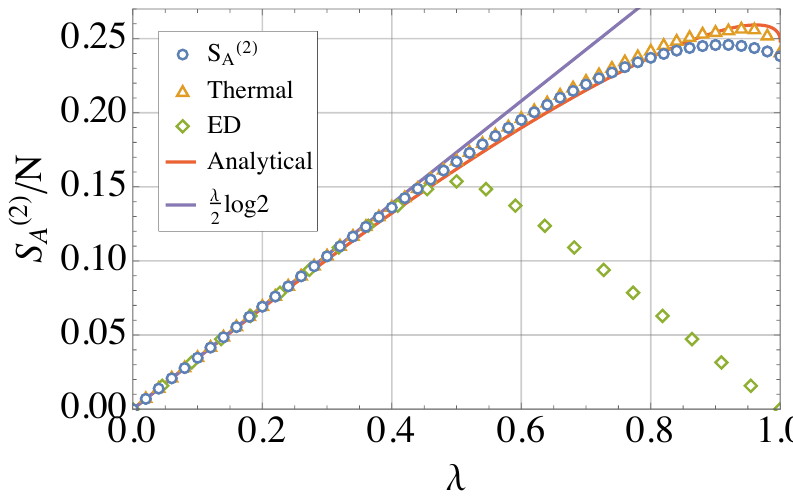
( 2 ) / N for β J = 50 and q = 4 for different λ (blue Figure 1: Subsystem entropy S A circle). The green square is the exact diagonalization result [ 1 ] . The yellow triangle is thermal entropy with the effective temperature obtained by numerically matching the energy density (8). We also plot the analytical approximation (9) using a red line and λ log2 / 2 using a purple